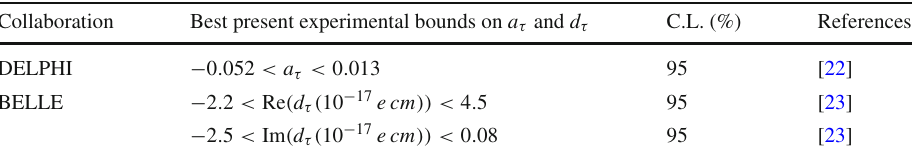
Collaboration Best present experimental bounds on a τ and d